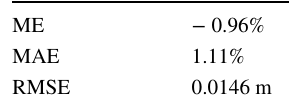
Table 4 Calculation of mean error, absolute mean error and root-mean-square error in unsteady